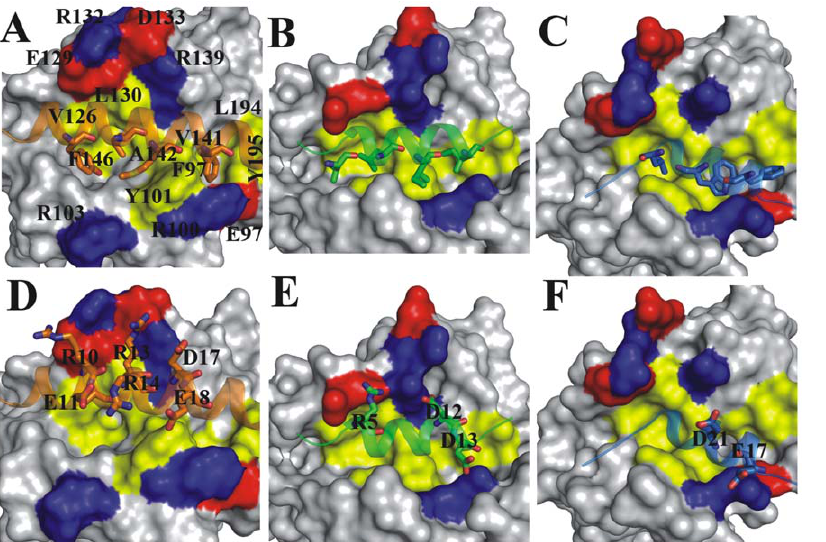
Figure 5. Hydrophobic and charged surface of Bcl-X L . The shallow hydrophobic pocket of Bcl-X L is shown with yellow color, positive and negatively charged residues present on the walls of the pocket represented with blue and red, respectively. The hydrophobic residues of peptides h1–h4 of Bad (A), Bak (B) and h2–h4 of SN15 (C) are highlighted as sticks which lock with hydrophobic pockets of Bcl-X L . Complimentary charged residues on Bad (D), Bak (E), SN15 (F) are highlighted as sticks and labeled accordingly.